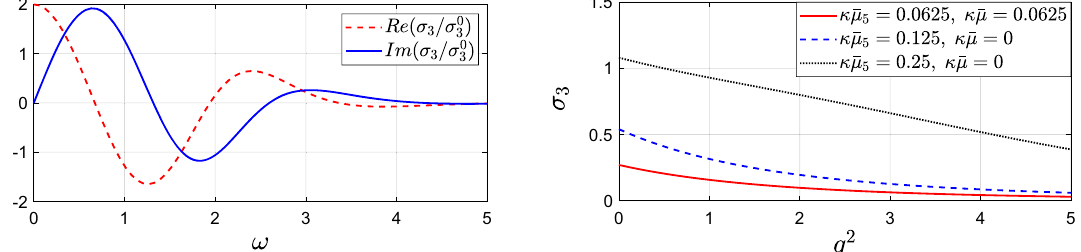
when q = 0 (left); q 2 -dependence of σ 3 when ω = 0 3